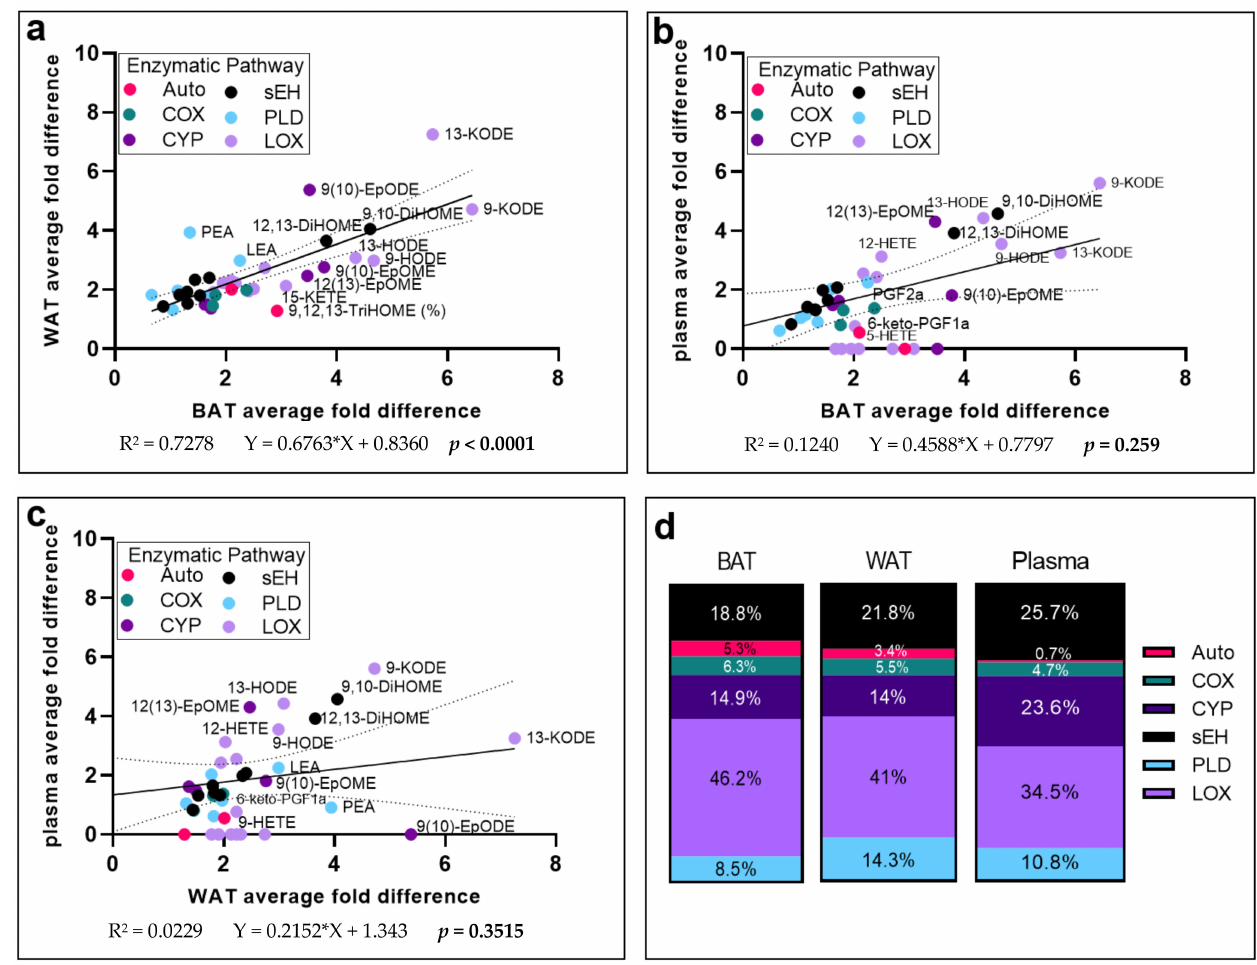
Figure 4. Correlations of average fold difference of mice consuming the SOLF diet compared to the POLF diet among brown adipose tissue, white adipose tissue, and plasma. Average fold difference was calculated for those lipid mediators that were changed by diet in univariate analysis in at least one of the three tissues reported. Average fold difference (reported in Table 1) was calculated by dividing the average of each metabolite in the SOLF diet by that of the POLF diet. Regression analysis was used to determine similarities in fold changes in ( a ) WAT vs. BAT, ( b ) BAT vs. plasma, and ( c ) WAT vs. plasma, reported here with 95% confidence intervals. Those metabolites not detected in one of the two tissues was included as a value of 0. p < 0.05 indicates a correlation significantly different from